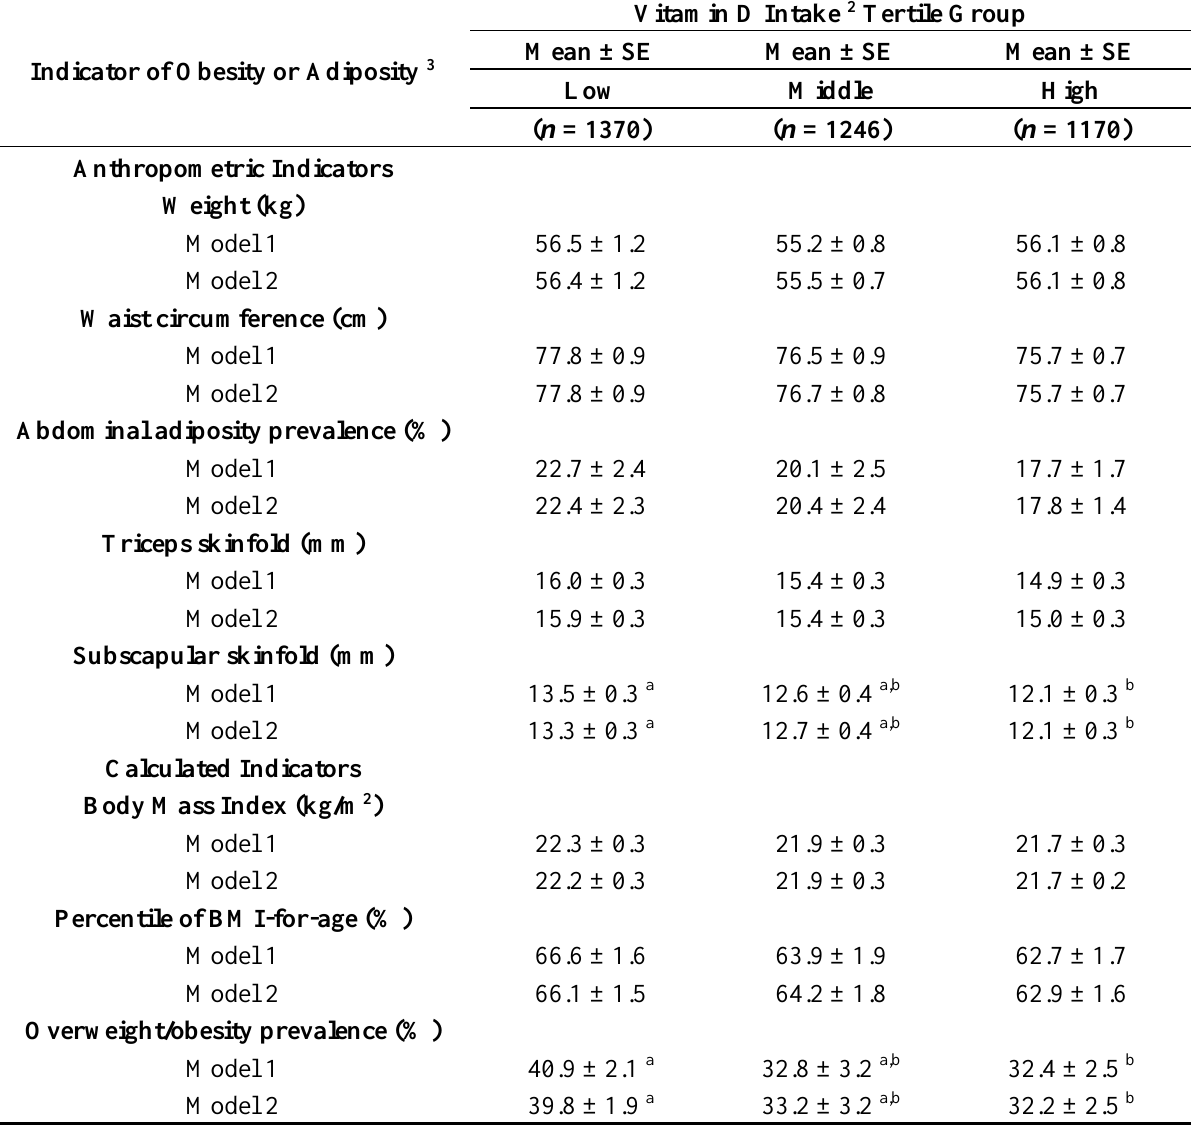
Table 6. Covariate-adjusted mean value of obesity or adiposity indicator by vitamin D intake 1 .